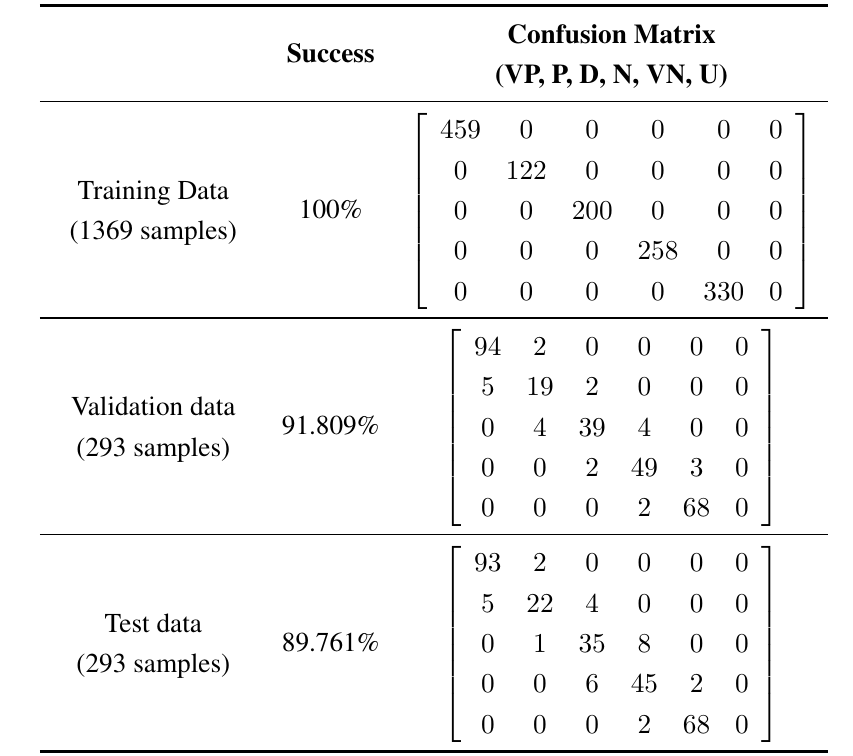
Table 4. Evaluation of the classifier for the test lines in non-alcohol strip lateral histograms. Note that confusion matrices have dimensions of 5 × 6 because “undetermined” samples were never considered as an input. “Undetermined” samples are just the classification output when a certain confidence level is not